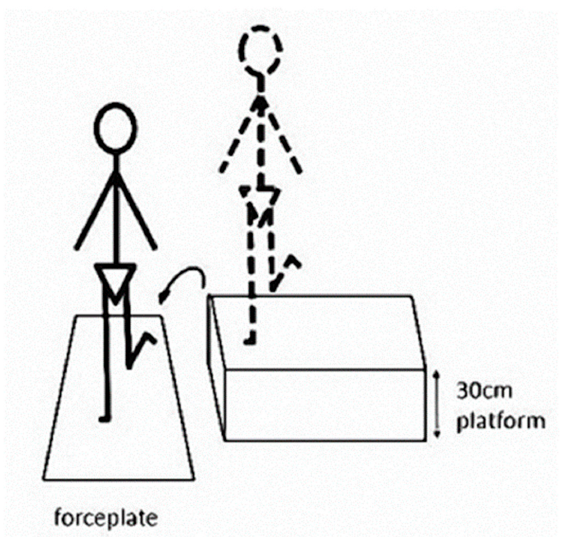
Figure 2. Schematic illustration of single-leg lateral drop landing task.